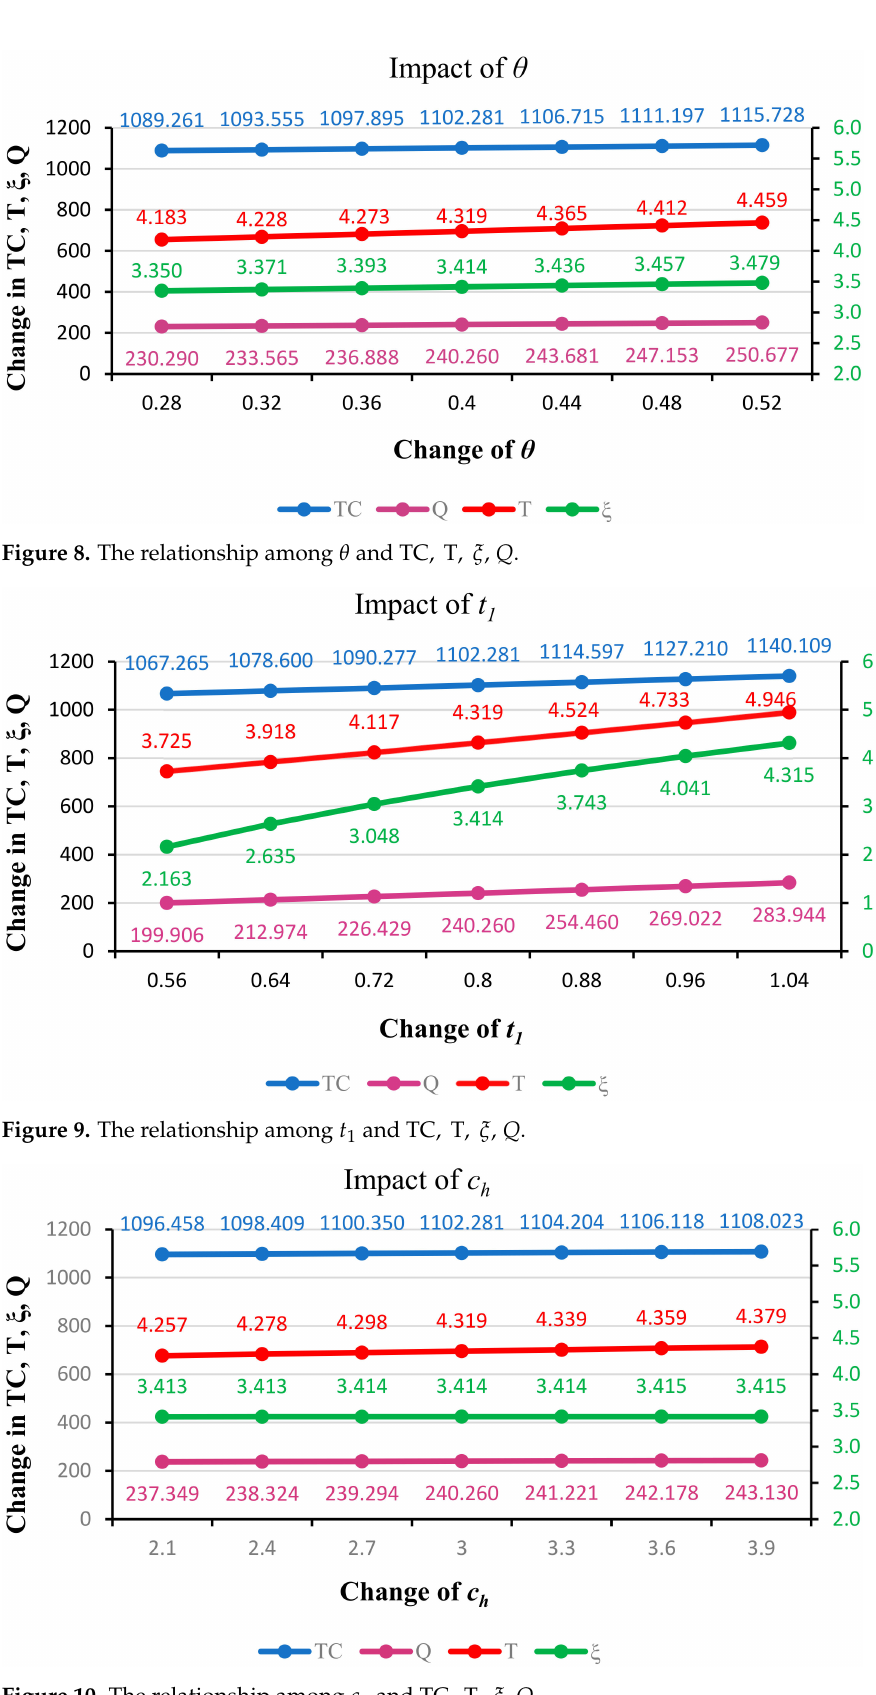
Figure 10. The relationship among c h and TC, T, ξ , Q